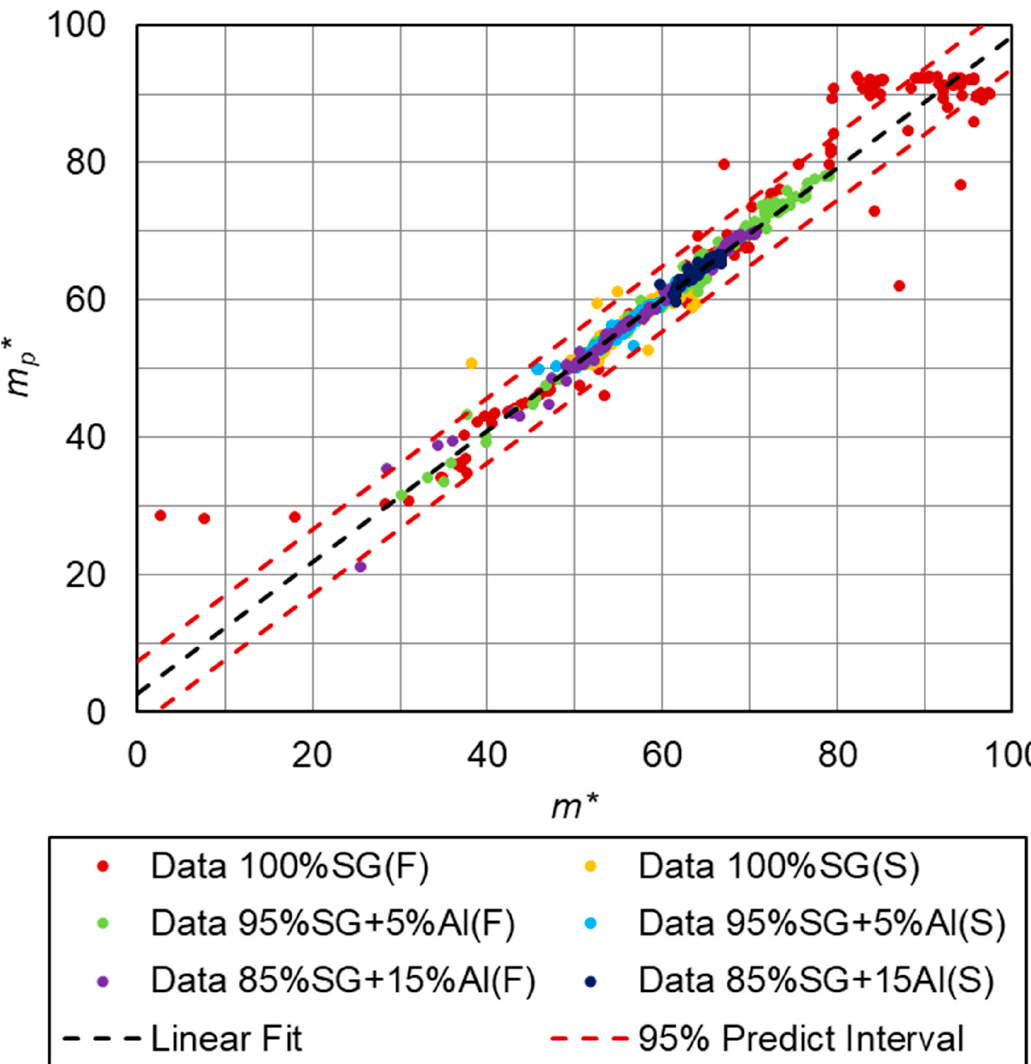
Figure 11. Comparison of the experimental results with the numerical results predicted by the LSTM (80-10-10).